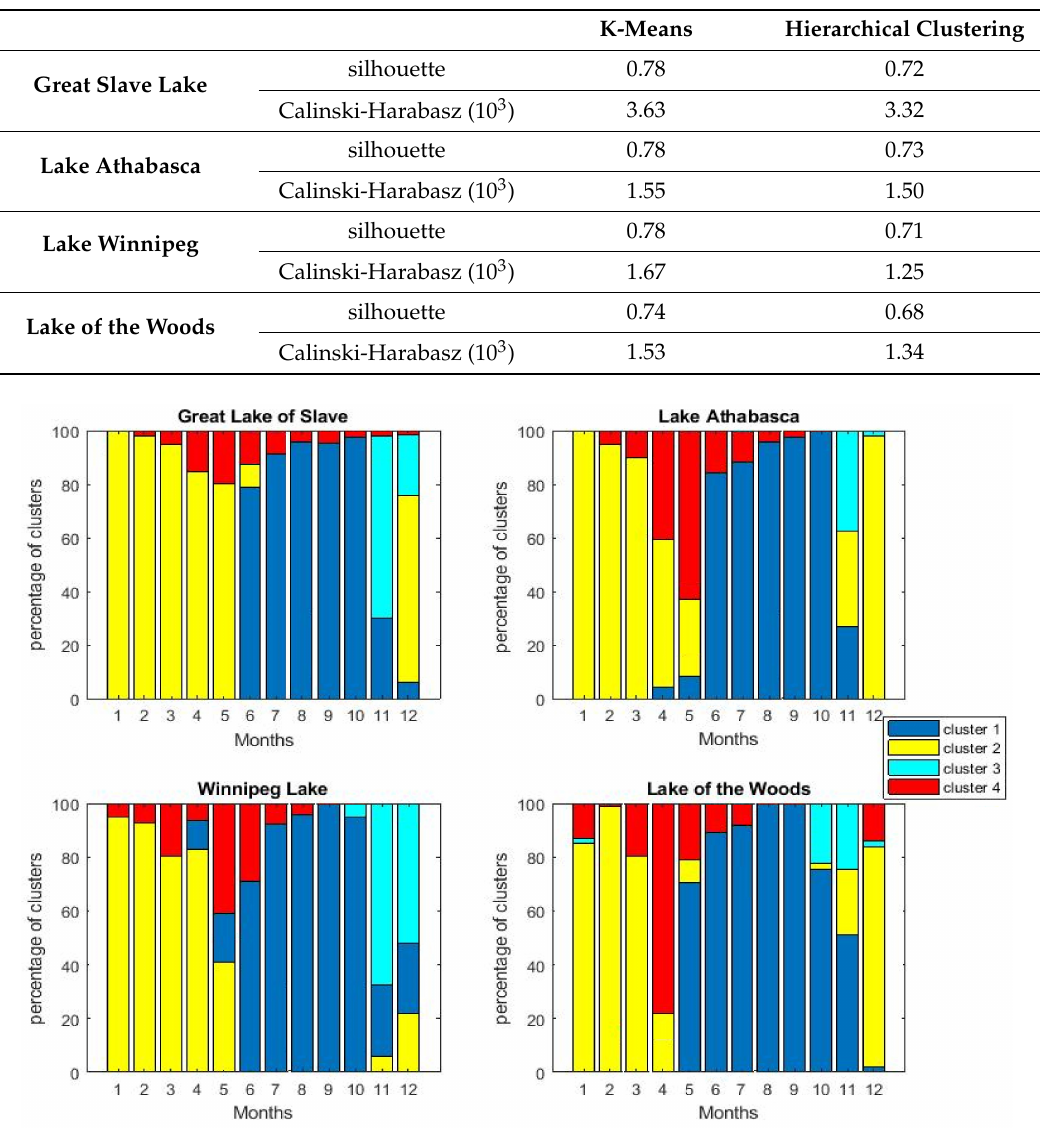
Table 4. Results of the silhouette and Calinski-Harabasz objective criteria for every lake.